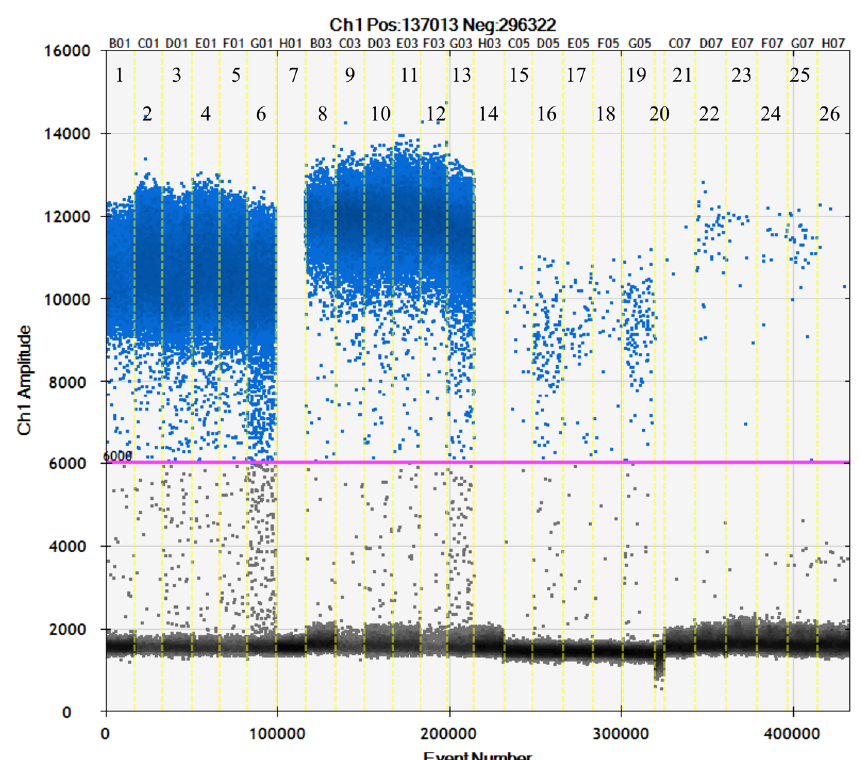
Figure 4. ddPCR detection of the EPO transgene in plasma and urine after intramuscular administration to a horse. The horizontal axis shows the number of each sample. Times are all post-administration. Plasma: lanes 1 and 8: 15 min; lanes 2 and 9: 1 h; lanes 3 and 10: 3 h; lanes 4 and 11: 6 h; lanes 5 and 12: 12 h; lanes 6 and 13: 1 day; and lanes 7 and 14: 2 days. Urine: lanes 15 and 21: 50 min; lanes 16 and 22: 3 h; lanes 17 and 23: 6 h; lanes 18 and 24: 12 h; lanes 19 and 25: 1 day; and lanes 20 and 26: 2 days. Lanes 1 through 7 and 15 through 20 were amplified using SET1, and lanes 8 through 14 and 21 through 26 were amplified using SET2. The vertical axis shows PCR amplitudes (fluorescence intensity). The pink line is the detection threshold. ddPCR amplification of lanes 1 through 14 was performed using SDs of DNA extracts; therefore, amplification was not observed for 2-day samples (lanes 7 and 14).